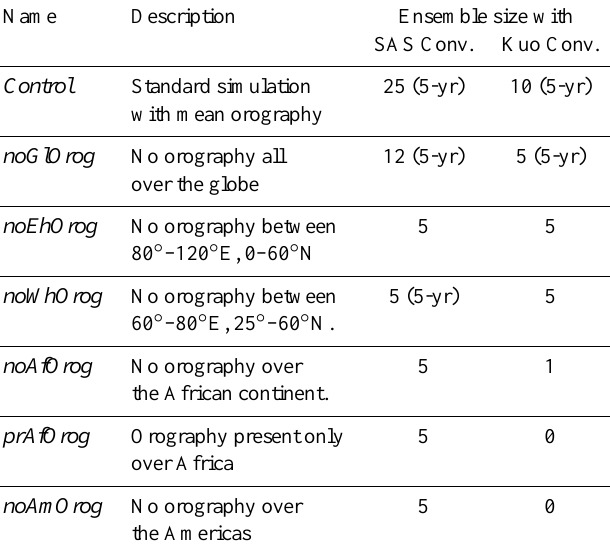
Table 1. Nomenclature for different perturbed orography simulations and the total number of integrations performed in each experiment including the control simulations with two different cumulus parameterization schemes. For some simulations one member of the ensemble was integrated for 63 months (5.25 years). These are identified as parenthesized (5-yr) in the